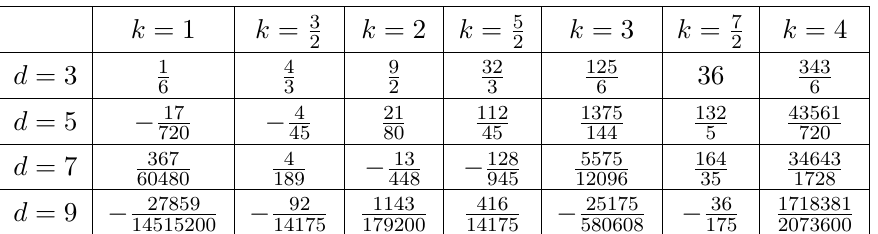
theory induced by the Ψ (1 , 0)